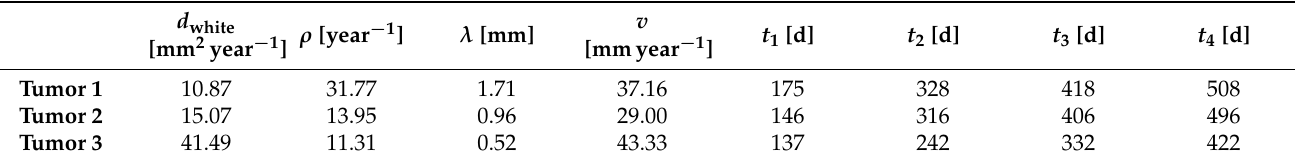
Table 2. Parameter values used for the tumor simulations in Figure